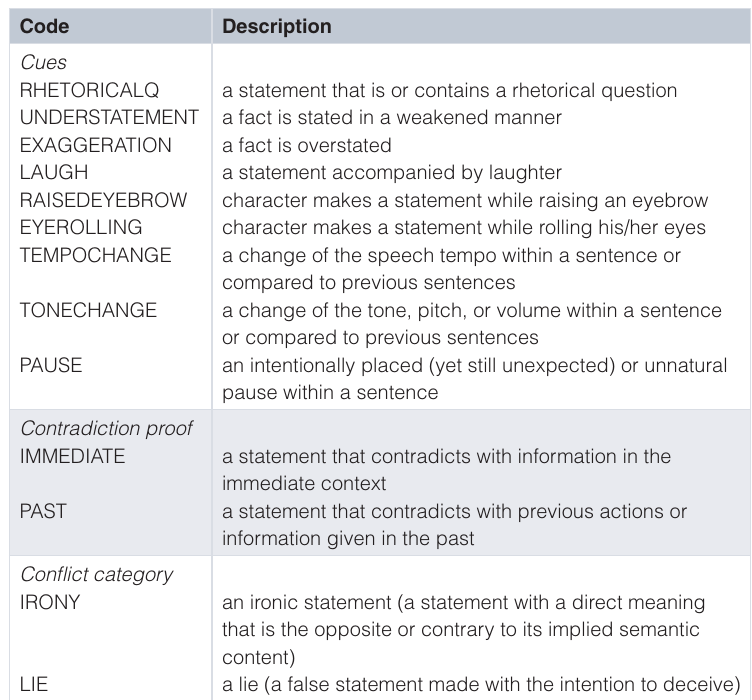
Table 1. Definitions for all annotation